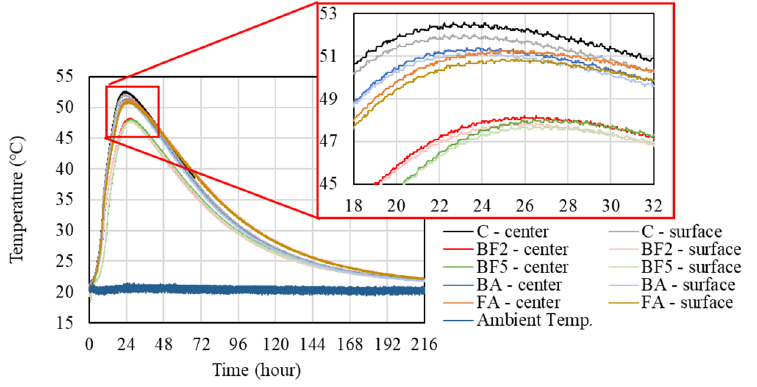
Figure 5. Heat of hydration of cement.